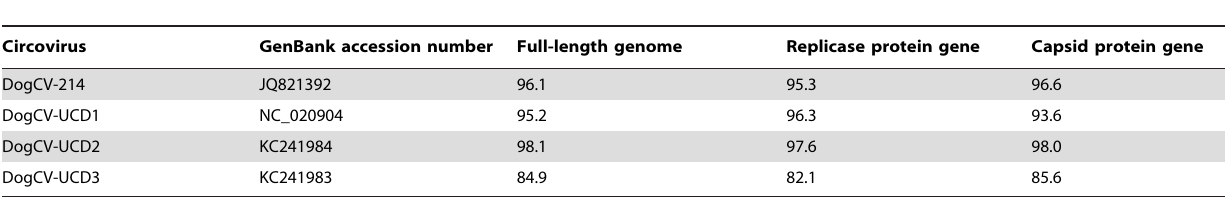
Table 1. Nucleotide identities (%) of DogCV Bari/411–13 with reference canine circoviruses in different genomic